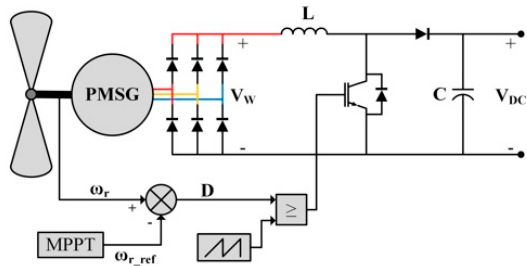
Figure 2. Overall control structure of the wind energy system.